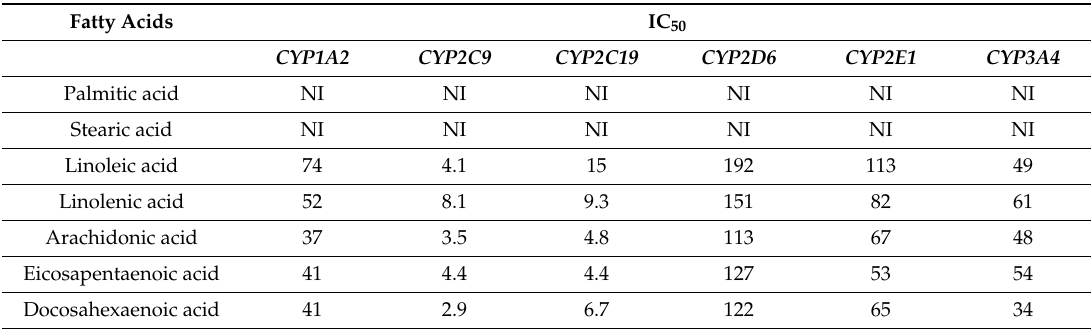
Table 6. E ff ect of saturated and unsaturated fatty acids where, saturated fatty acids showed NI (no inhibition) and unsaturated inhibited all CYP